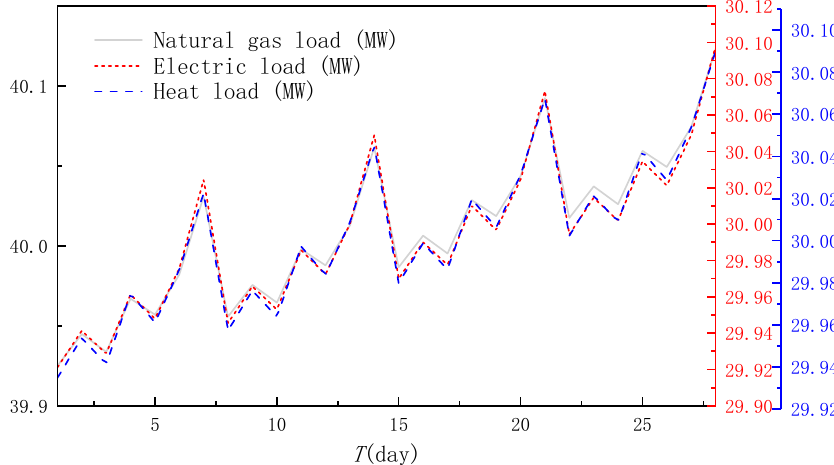
Figure 9. Flexible load growth in a month.